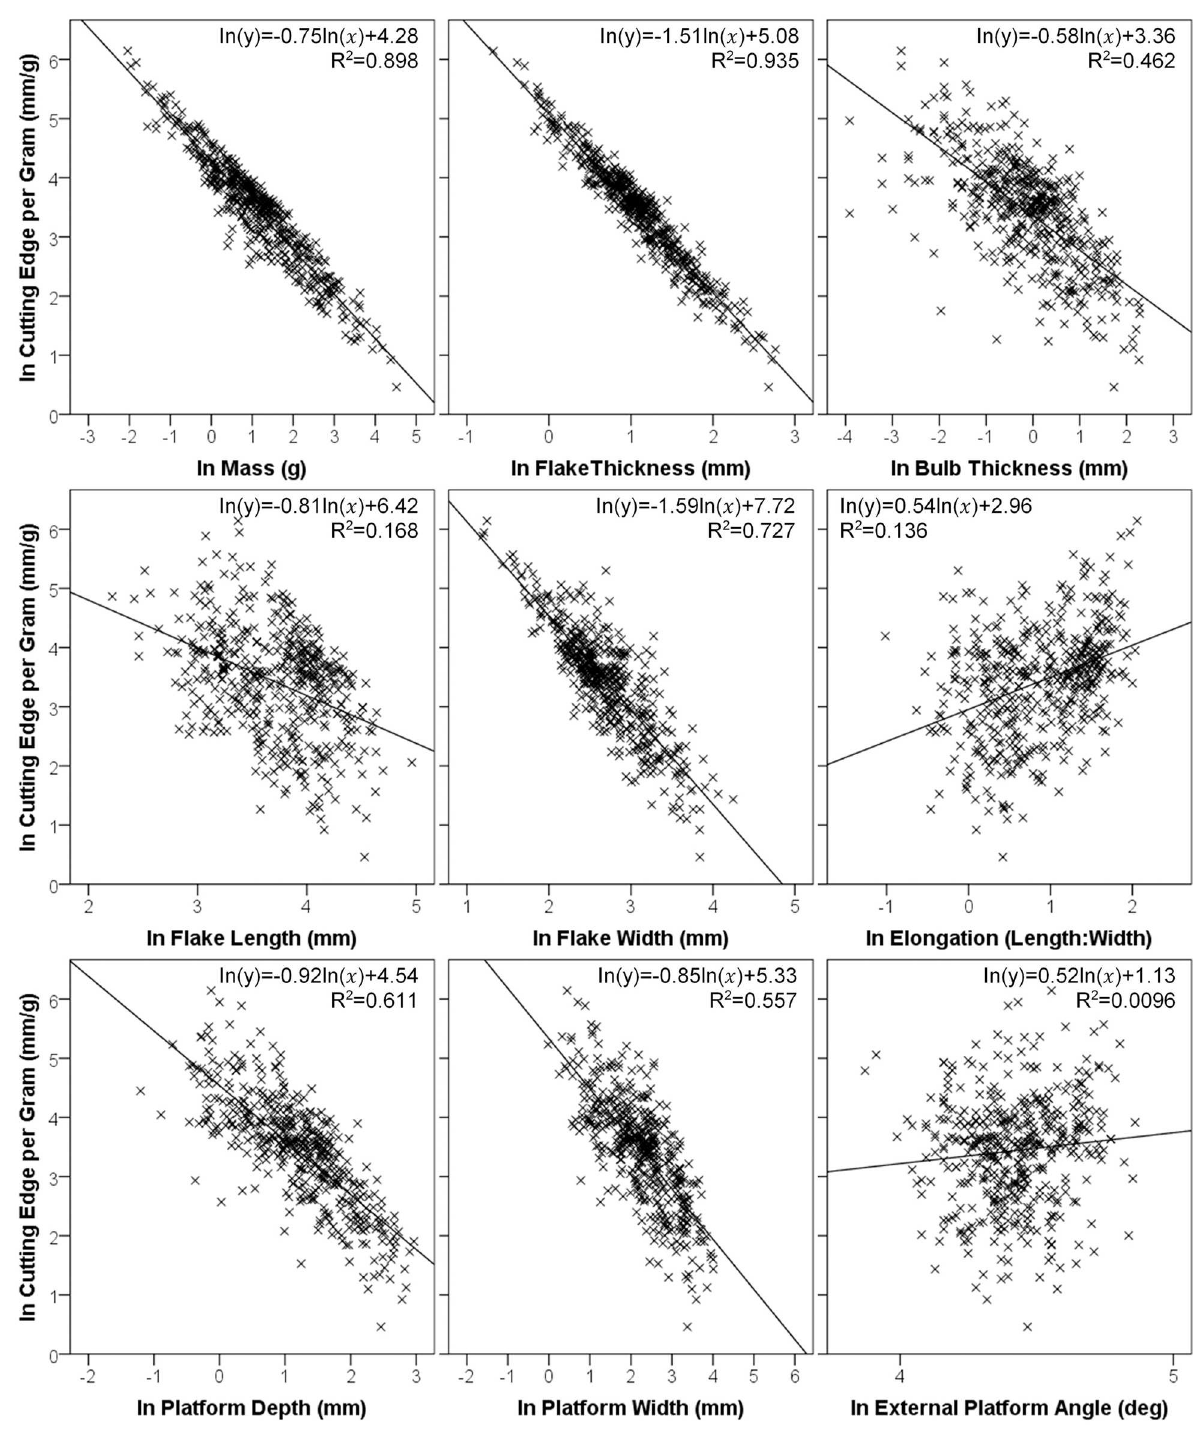
Fig 4. Scatter plots with both axes transformed using the natural log (ln) examining the influence of mass, thickness, bulb thickness, length, width, elongation, platform depth, platform width and exterior platform angle (EPA) on the cutting edge length per gram of core for individual flakes. The sample size of each scatter plot is 488, except for the platform depth, platform width and EPA scatter plots, which had sample sizes of 460 owing to the presence of some crushed